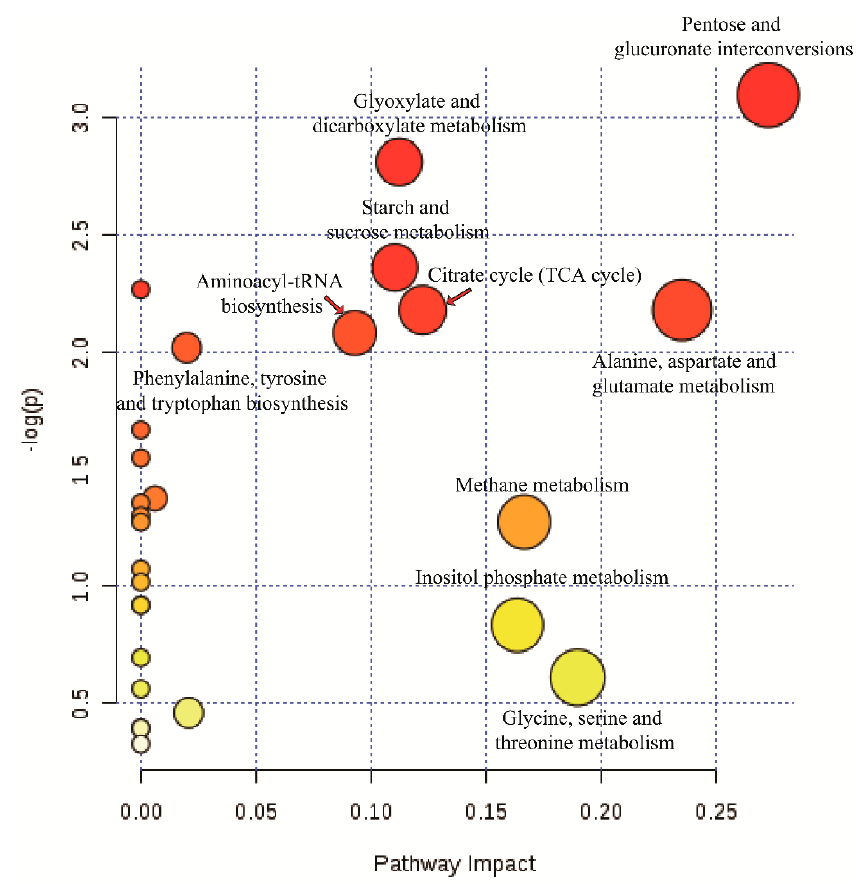
Figure 9. Pathway analysis of the differential metabolites from virus-free and -containing isogenic strains. Plots depicting computed metabolic pathways as a function of − log ( p ) and pathway impact for the key differential metabolites from GD-118P vs. GD-118P-V1.